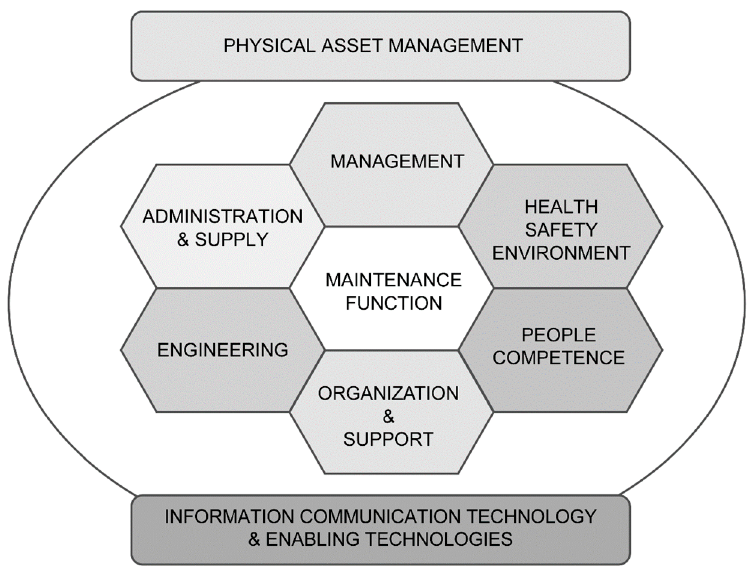
Figure 1. Maintenance functions and core framework (source: CEN [26]).